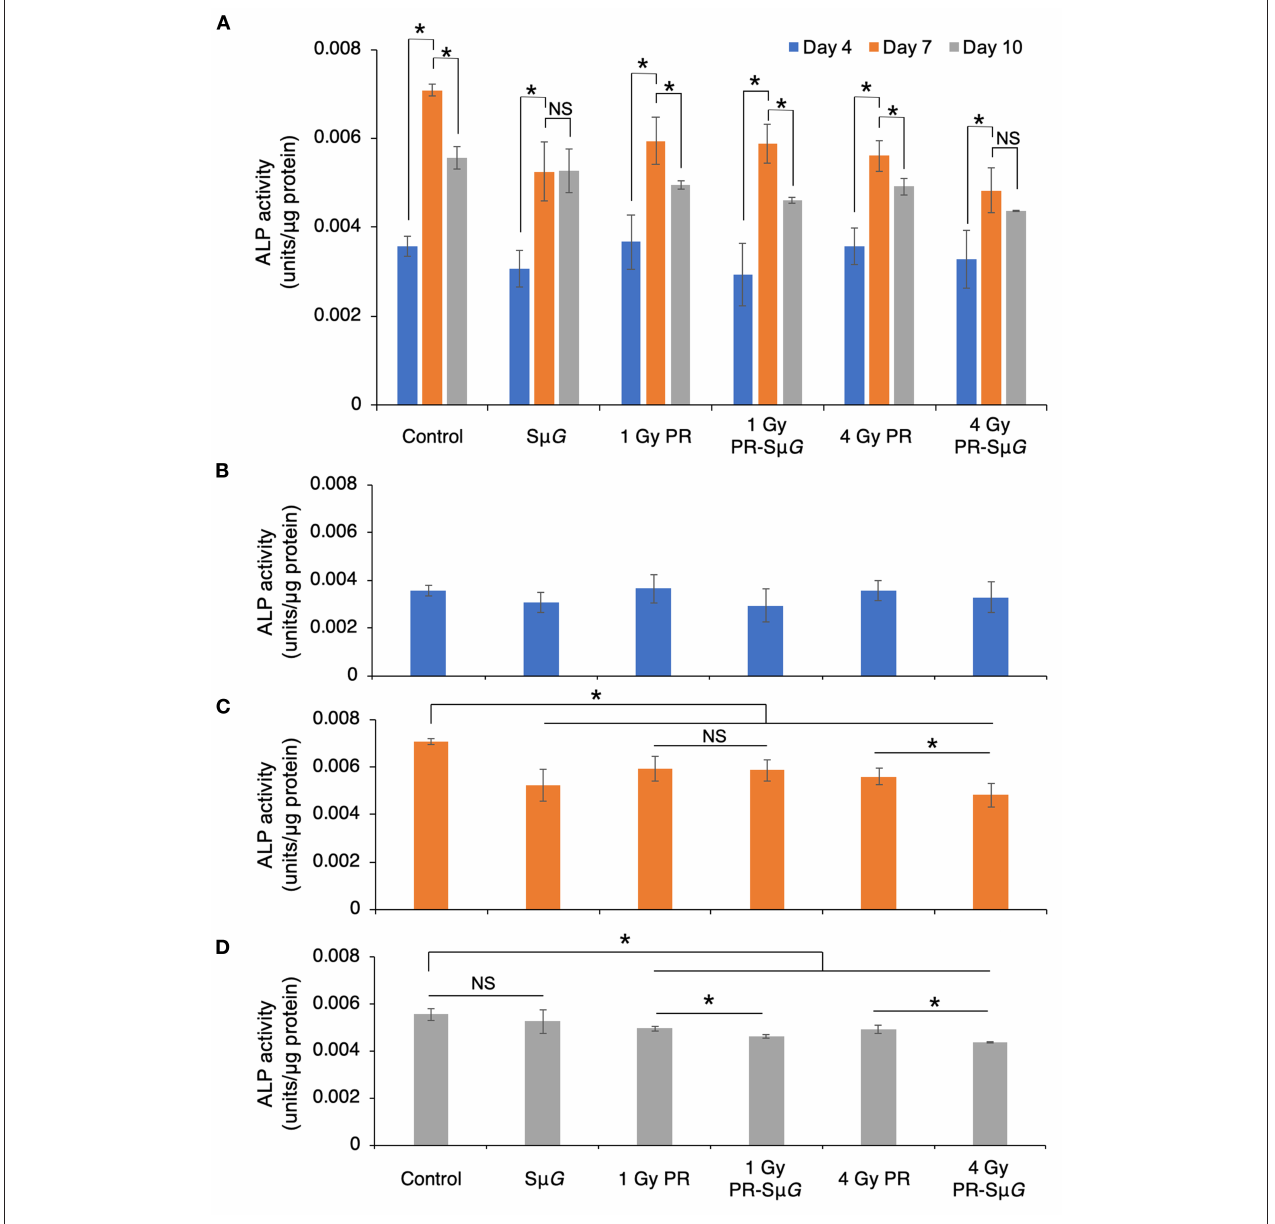
FIGURE 3 | Effects of S µ G , PR, and their combination on ALP activity. (A) Time course of ALP activity. ALP activity at day 4 (B) , day 7 (C) , and day 10 (D) posttreatment. The mean values with standard errors are shown. * p < 0.05, NS indicates not significant ( p > 0.05) (Student’s t -test). Symbols: day 4 (blue column), day 7 (orange column), and day 10 (gray column). The bars indicate the standard errors calculated using data from three independent trials.